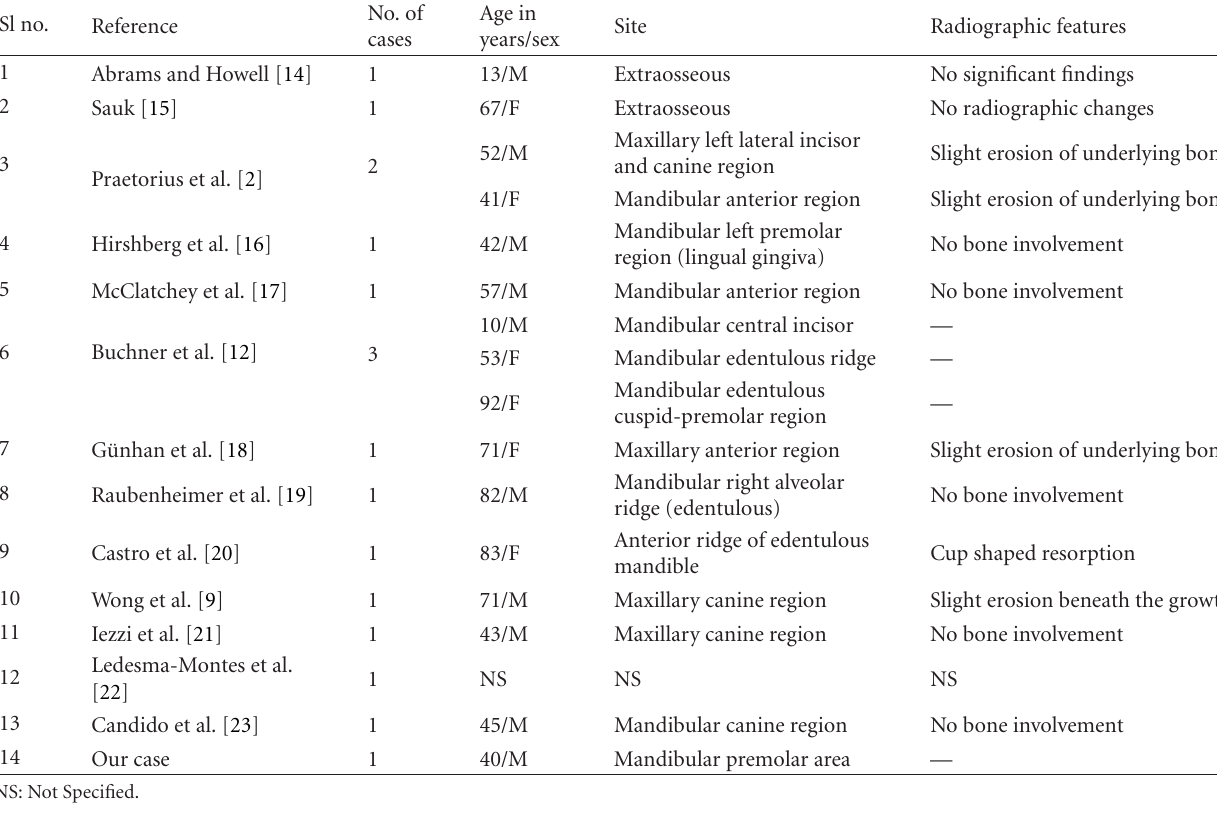
Table 1: Reported cases of peripheral dentinogenic ghost cell tumor.